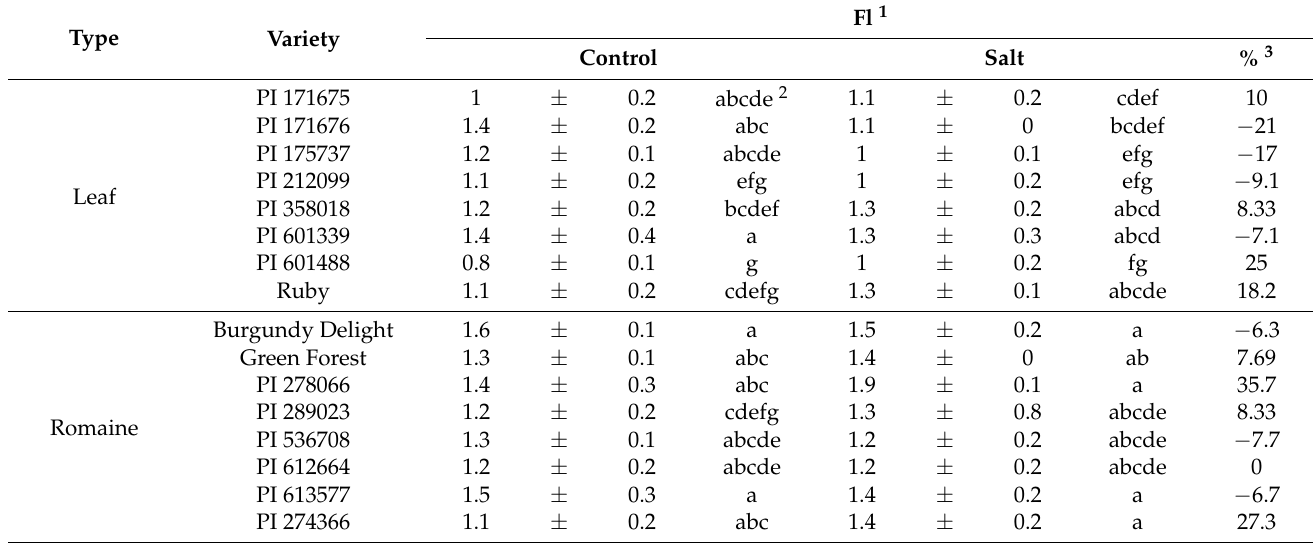
Table 10. Flavonoid index (FI) (mean ± standard deviation, n = 6) of leaf- and romaine-type lettuce cultivars grown under control and salt-stress conditions (100 mM) after 42 days of sowing (10 days after salt treatment).